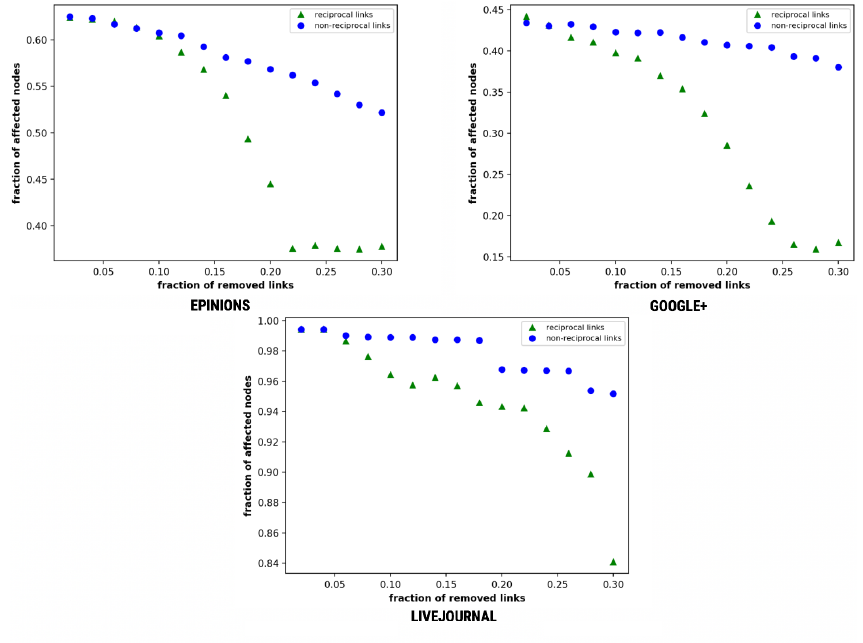
Figure 4. Multiple diffusion—fraction of affected nodes as a function of the fraction of removed